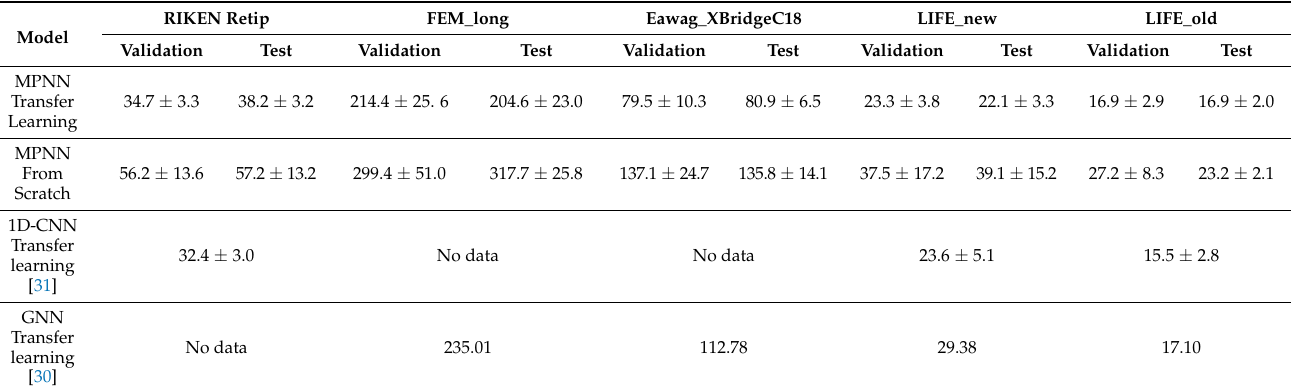
Table 2. Mean absolute error (in seconds) for 5-fold cross-validation of MPNN compared with previously published results.